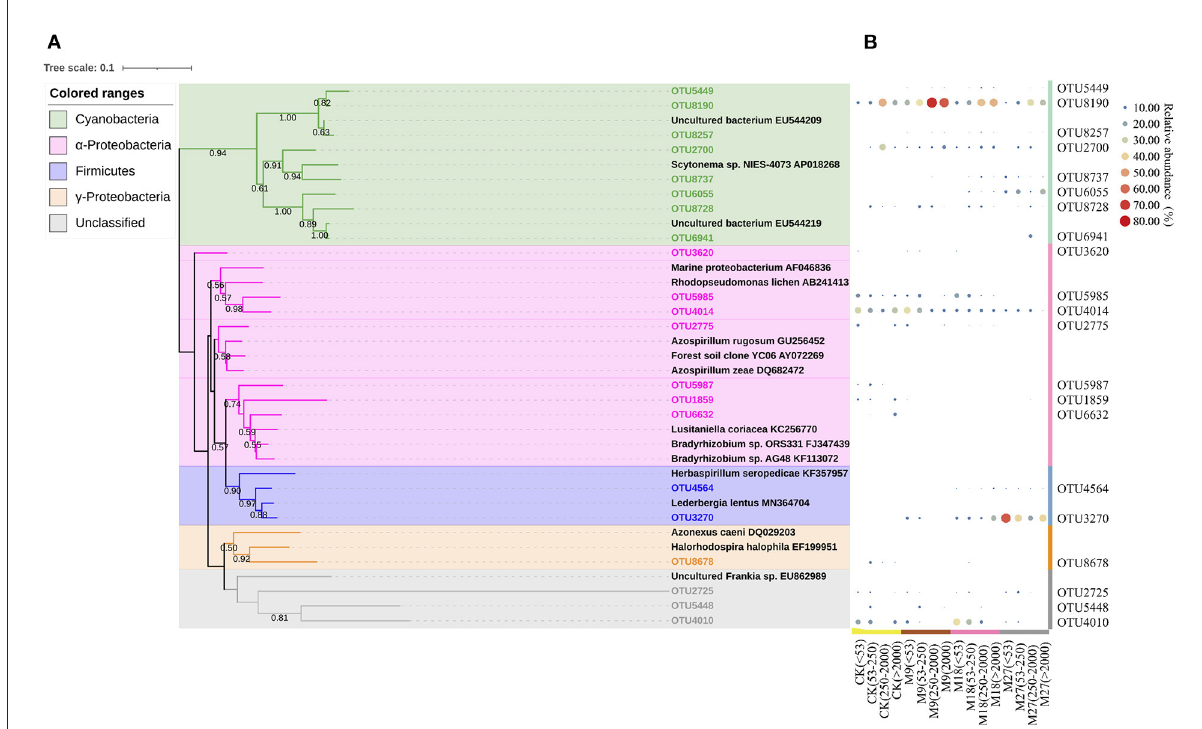
FIGURE5 Phylogenetic tree shows the relationship between the representative sequences from this study and reference sequences from GenBank (A) . The colored ranges indicate different phylotypes of diazotrophs. Bootstrap values of > 50% based on 1,000 replicates are shown next to the branches. The scale bar represents 0.1 nucleic acid sequence divergence. Panel (B) shows the heatmap of the relative abundance of each OTU to the diazotrophic sequences in each treatment. The relative abundances of OTUs are indicated by bubble